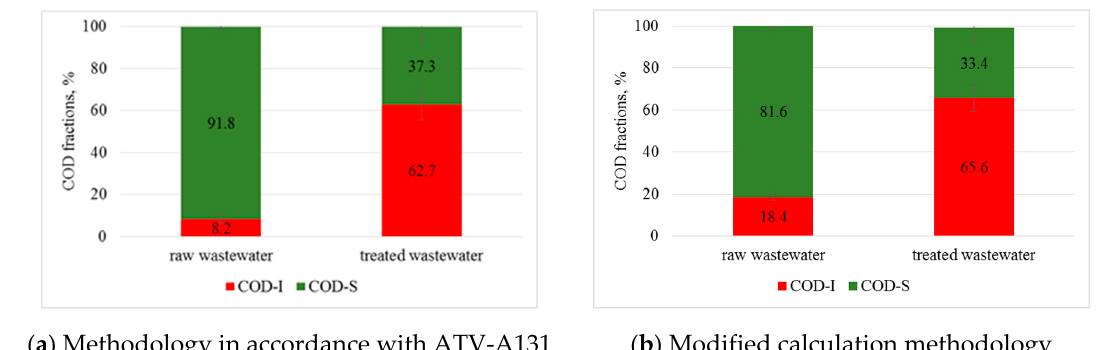
Figure 4. Total share of COD biodegradable and non-biodegradable fraction in raw and treated wastewater. ( a ) Methodology in accordance with ATV-A131; ( b ) modified calculation methodology.